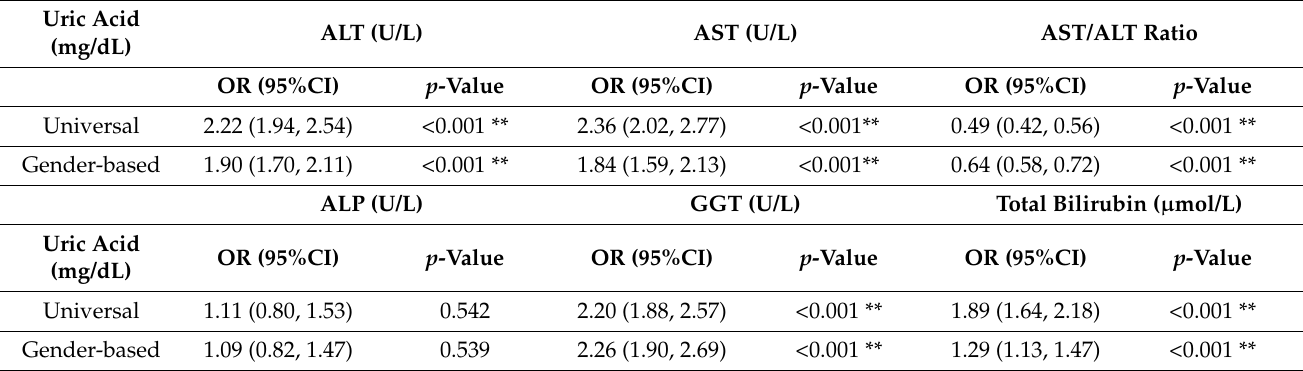
Table 4. Odds of Elevated Liver Enzymes with Uric acid (Universal and gender-based cut-off